Question: Compose a caption that would accompany this figure in a paper.
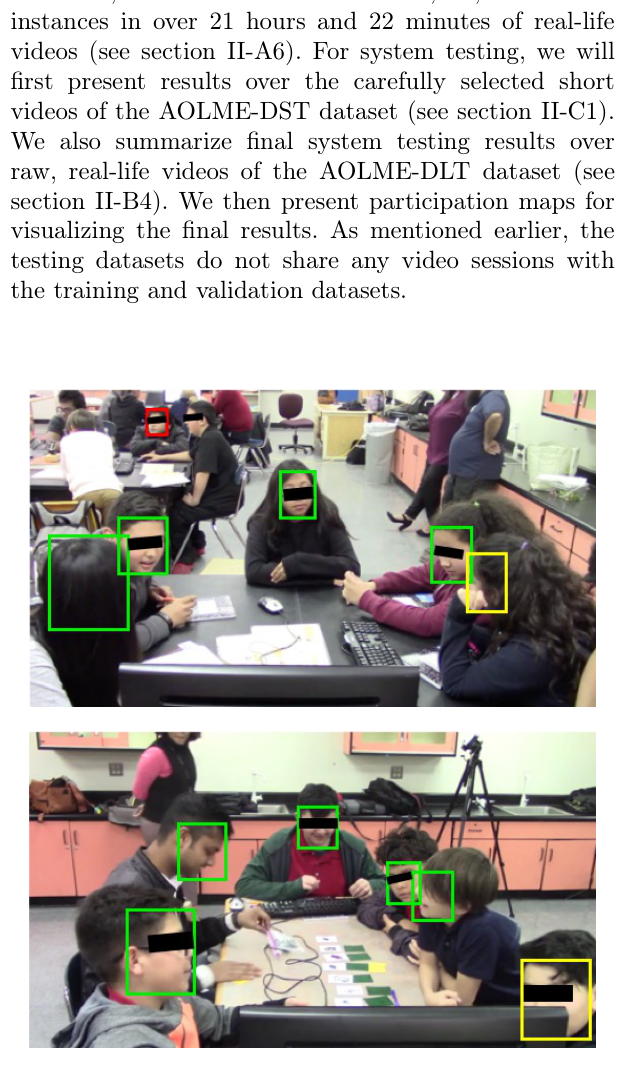
Answer: Head detection system results. True positives are bounded by green boxes. False positives are bounded by red boxes. False negatives are bounded by yellow boxes. For successful detection, we require the intersection over union (IOU) score to be at least 0.6.